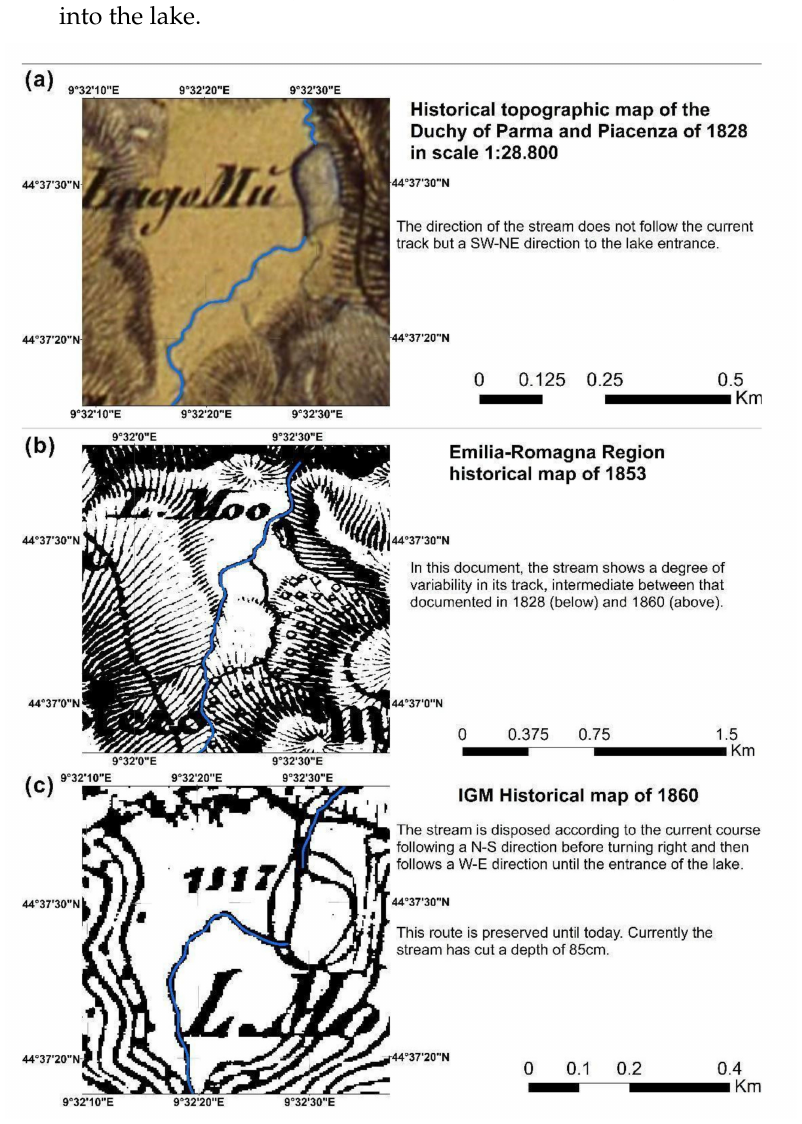
Figure 5. Historical cartography available for the study area. The blue line shows the different tracks of the main stream under study. ( a ) Historical topographic map of the Duchy of Parma and Piacenza of 1828 in scale 1:28,000; ( b ) Emilia-Romagna Region historical map of 1853; ( c ) IGM Historical map of